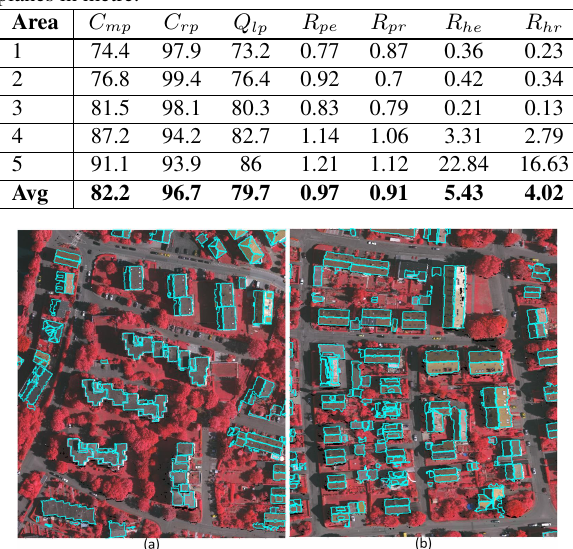
Table 4: Pixel-based and geometric evaluation of plane extraction results. Pixel-based: C mp = completeness, C rp = correctness and Q = quality in percentage. Geometric: planimetric accuracy lp with respect to R pe = extracted and R pr = reference planes and height error with respect to R = extracted and R = reference he hr planes in metre.